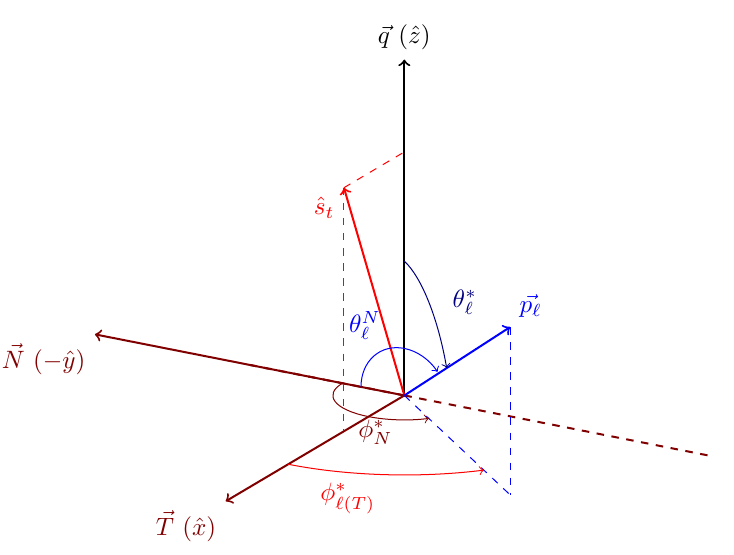
Figure 2. Coordinate system and angles used to de(cid:12)ne the W -boson spin observables and their related angular asymmetries in the decay of polarised top quarks. The W -boson momentum ~q in the top-quark rest frame de(cid:12)nes the ^ z -axis; the top-quark spin direction ^ s t , taken along the spectator-quark momentum in the top-quark rest frame, de(cid:12)nes the ^ x {^ z plane. The polar and azimuthal angles of the charged-lepton momentum ~p ‘ in the W -boson rest frame are labelled (cid:18) (cid:3) ‘ and (cid:30) (cid:3) , respectively. The normal and transverse axes are de(cid:12)ned relatively to ~q and ^ s t according to ‘ ~N = ^ s ~T = ~q ~N ; they are along the ^ y and ^ x axes of the coordinate system, respectively. t (cid:2) ~q and (cid:2) (cid:0) The azimuthal angles (cid:30) (cid:3) and (cid:30) (cid:3) of the charged lepton in the W -boson rest frame are de(cid:12)ned N T relatively to the ~N and ~T axes, respectively ( (cid:30) (cid:3) (cid:30) (cid:3) ), while (cid:18) N and (cid:18) T (not shown in the (cid:12)gure) T (cid:17) ‘ ‘ ‘ are the relative angles between ~p ‘ and the ~N and ~T axes,